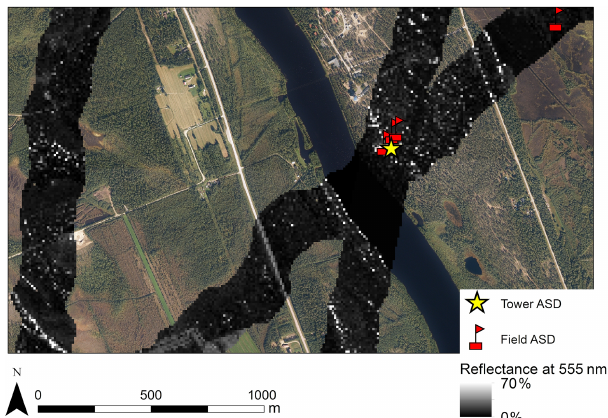
Figure 12. Airborne spectrometer reflectance at band 555nm on 5 May 2011 at 10m resolution. An orthophoto from summer time conditions is shown in the background (© National Land Survey of Finland, December